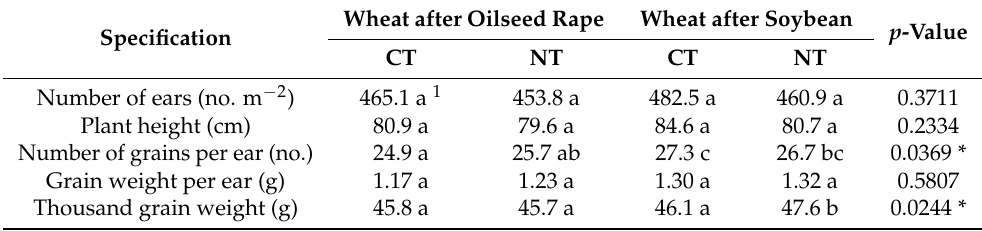
yield and crop components (mean for